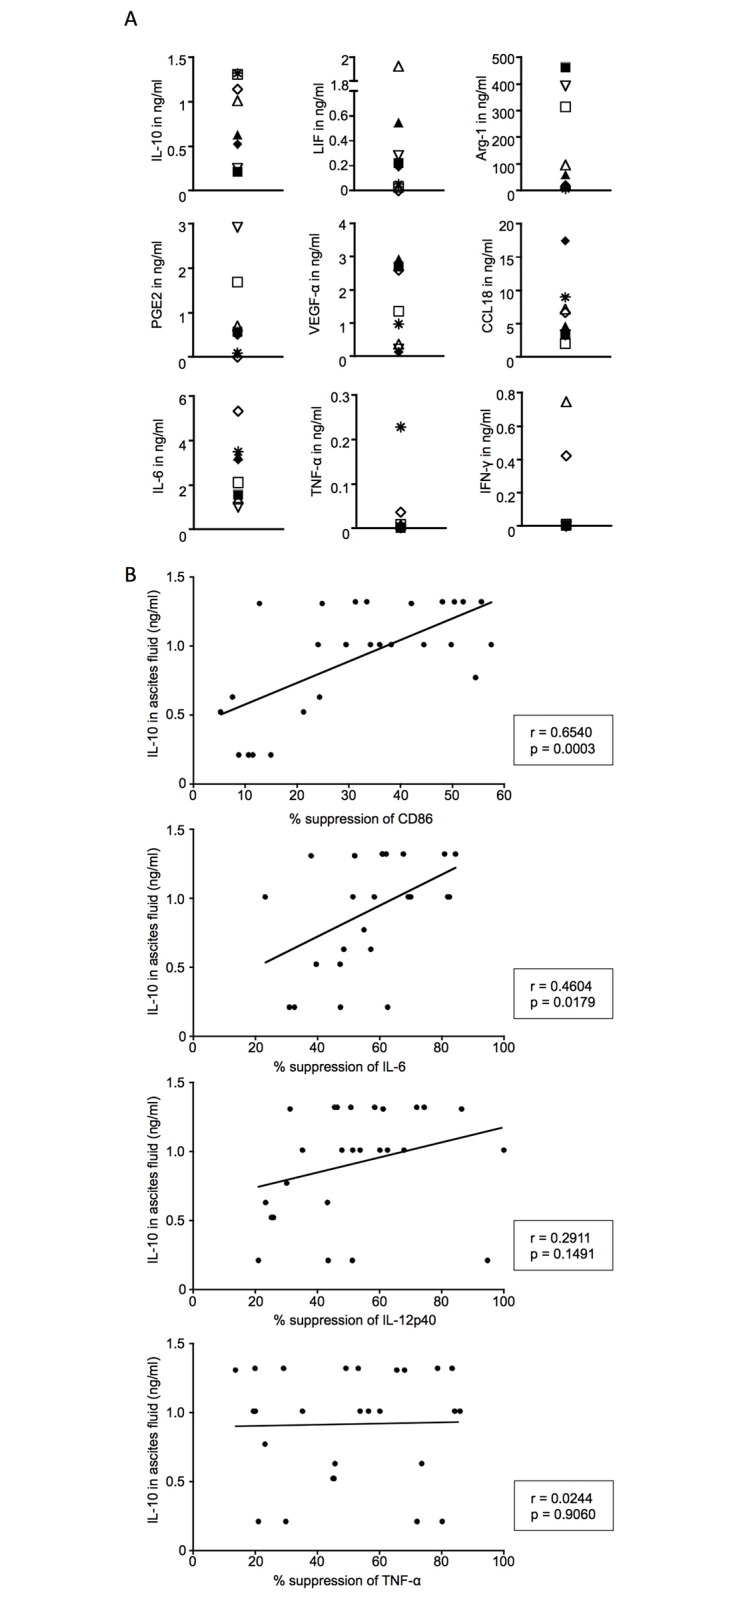
Levels of various immunomodulatory factors in OC-associated ascites and their correlation with the immunosuppressive effects observed in DC activation assays.(A) Protein levels of various factors in ascites samples collected from OC patients were measured by sandwich ELISA. Eight malignant ascites samples used throughout the study are shown. Each symbol represents one patient sample throughout the graphs (n = 8). (B) Levels of IL-10 in ascites samples are correlated to the suppression of TLR-mediated up-regulation of CD86 and production of IL-6, IL-12 and TNFα. Suppression is expressed in per cent reduction of surface marker and cytokine levels when 10% ascites was added to the cell culture as compared to no ascites present; n = 26 (26 independent experiments conducted with monocyte-derived DC from 9 different healthy controls, cultured with ascites from two (n = 4), three (n = 2) or four (n = 3) different OC patients. The Pearson coefficient was calculated to assess statistical significance of correlations.